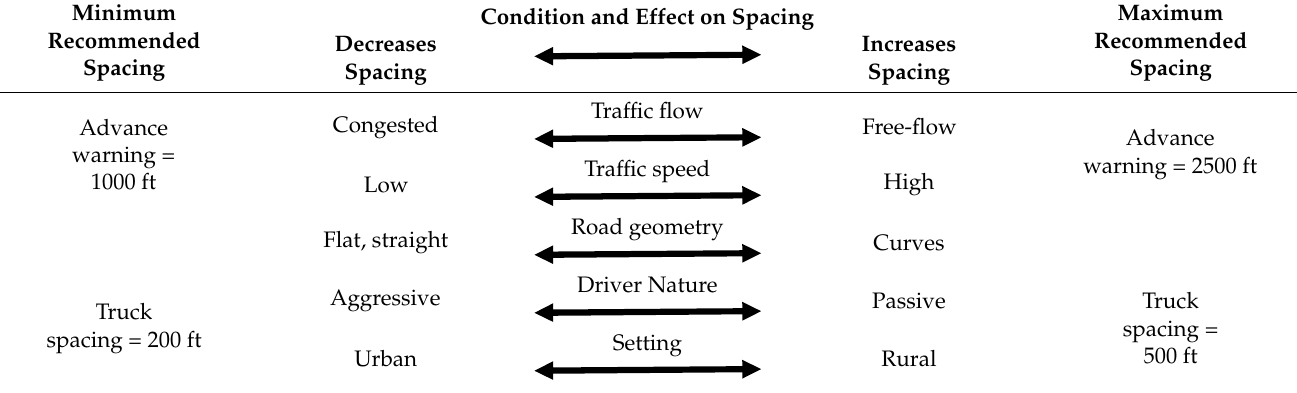
Table 12. Guidance for selecting advance warning and truck spacings [14].